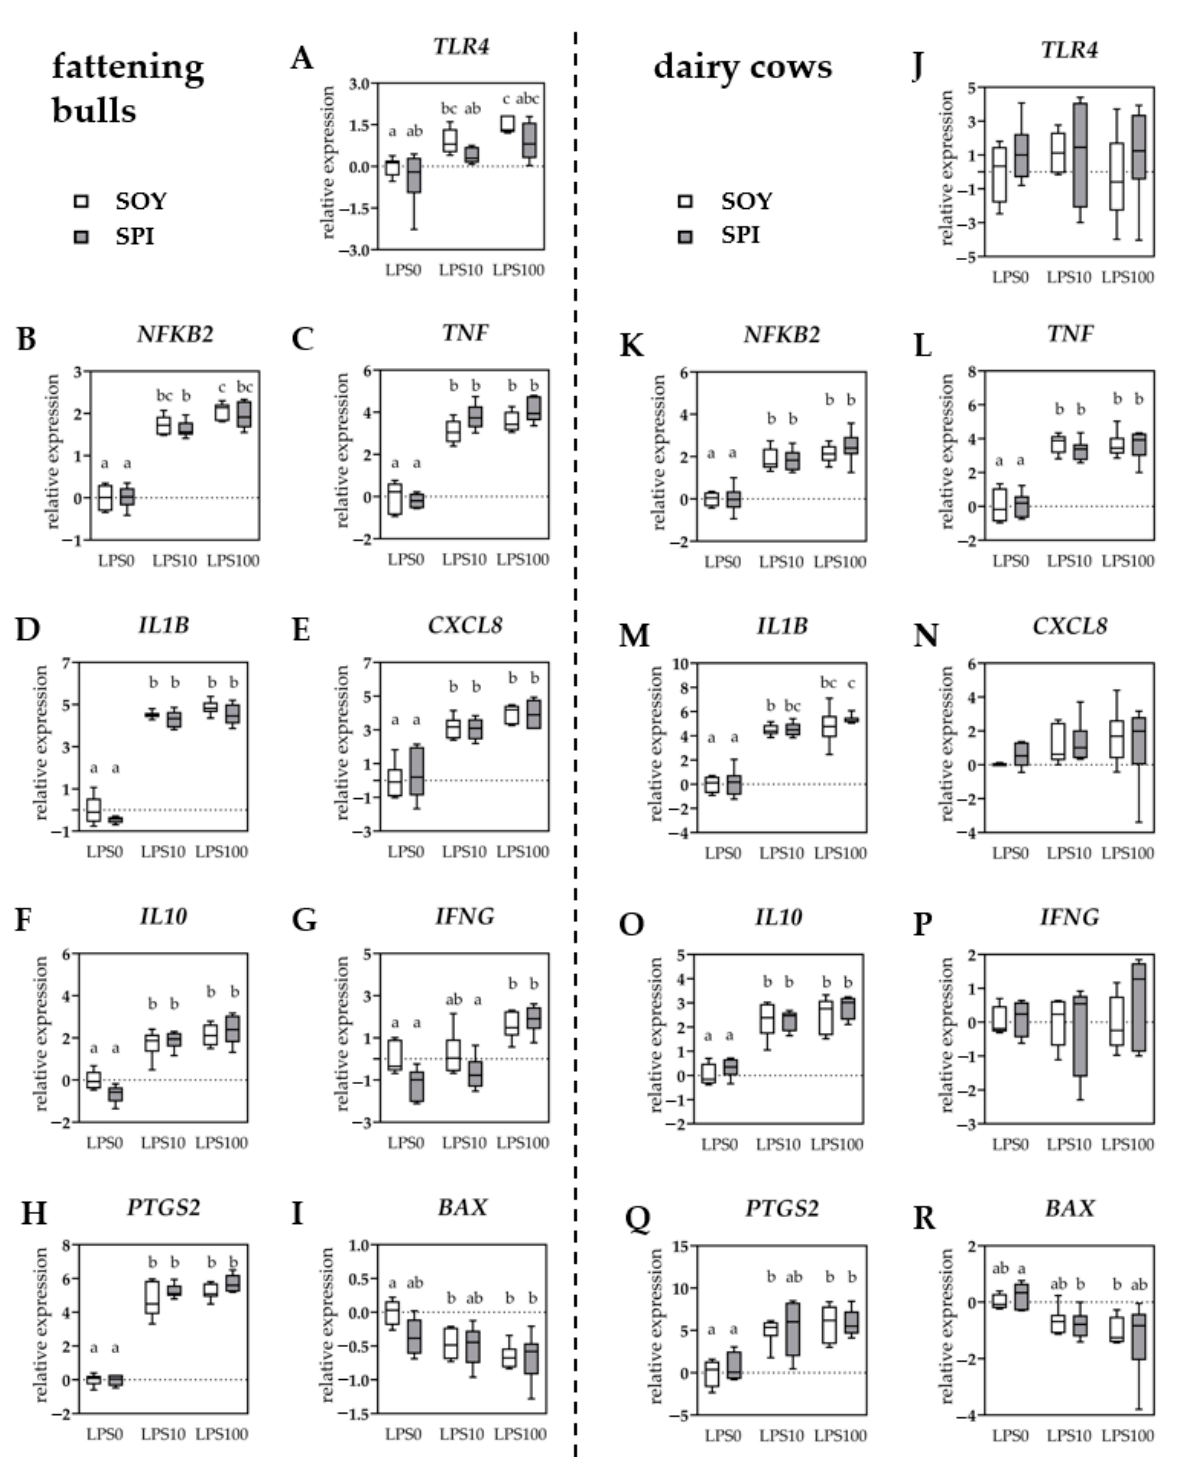
Figure 3. Relative expression of inflammation-related genes in peripheral blood mononuclear cells isolated from fattening bulls ( A – I ) and dairy cows ( J – R ) fed with soybean meal (white boxes) or spirulina (gray boxes) as protein source. Individual results were normalized to the mean of the respective SOY LPS0 group. Results are presented in boxplots with Spear style whiskers (min to max). Different lowercase letters indicate significant differences ( p ≤